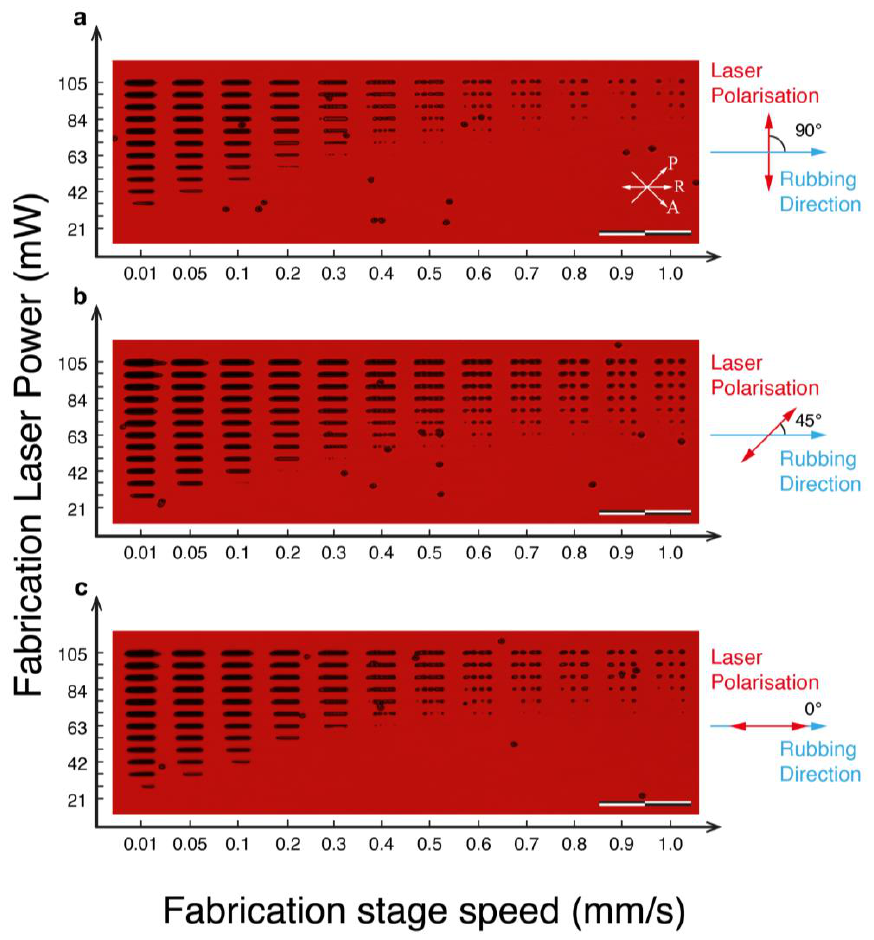
Figure 3. Laser written polymer walls in a polymerizable LC mixture for different fabrication laser powers and fabrication stage speeds when no voltage was applied to the LC during fabrication. Images were recorded on a polarizing optical microscope with an illumination source at 650 nm when the polarization of the writing laser was aligned at 90° (top), 45° (middle), or 0° (bottom) relative to the rubbing direction of the LC device. For these images, the rubbing direction was aligned at 45° to the transmission axes of the polarizer and analyzer pair and the scale bar in each image represents a length of 200 µm.